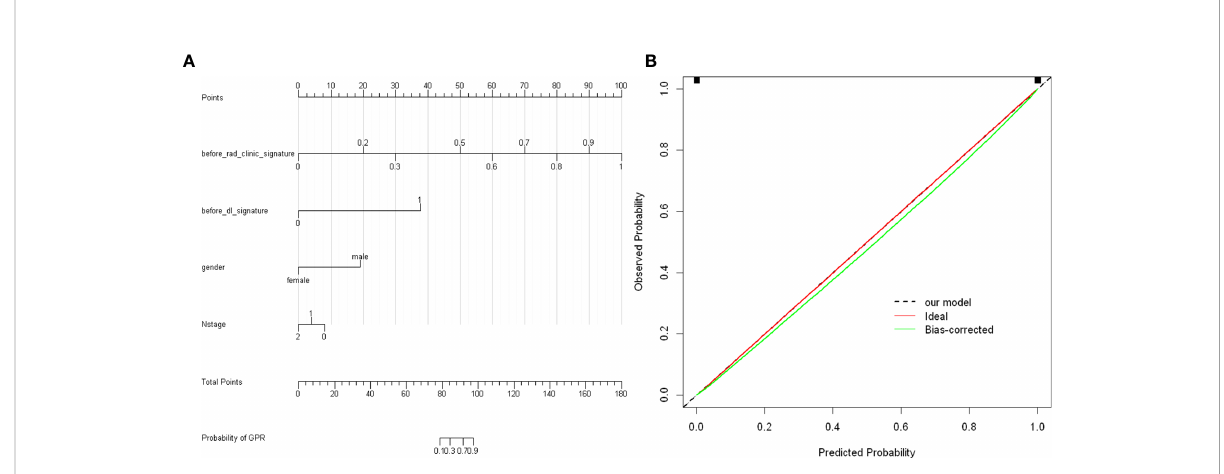
FIGURE 14 (A) before_nomogram.Locate on the before_rad_clinic_signature, before_dl_signature, gender, and N stage coordinate axis. Draw a straight line perpendicular to the fi rst points, calculate and sum the scores corresponding to each straight line, locate on the total points coordinate axis, and draw a straight line perpendicular to the horizontal axis of the probability of GPR. The corresponding value is the probability of pathological response to GPR in patients with non-small cell lung cancer after neoadjuvant immunotherapy. (B) Calibration curve corresponding to the before_nomogram. The consistency between the probability of GPR predicted by the nomogram after 1,000 repeated samplings and the actual GPR. The 45° red line represents the ideal prediction performance. The black dotted line and the solid green line represent the prediction performance of the nomogram and the correction of the deviation of the nomogram, respectively. The closer the black dotted line is to the 45° ideal red line, the higher the model ’ s prediction accuracy.